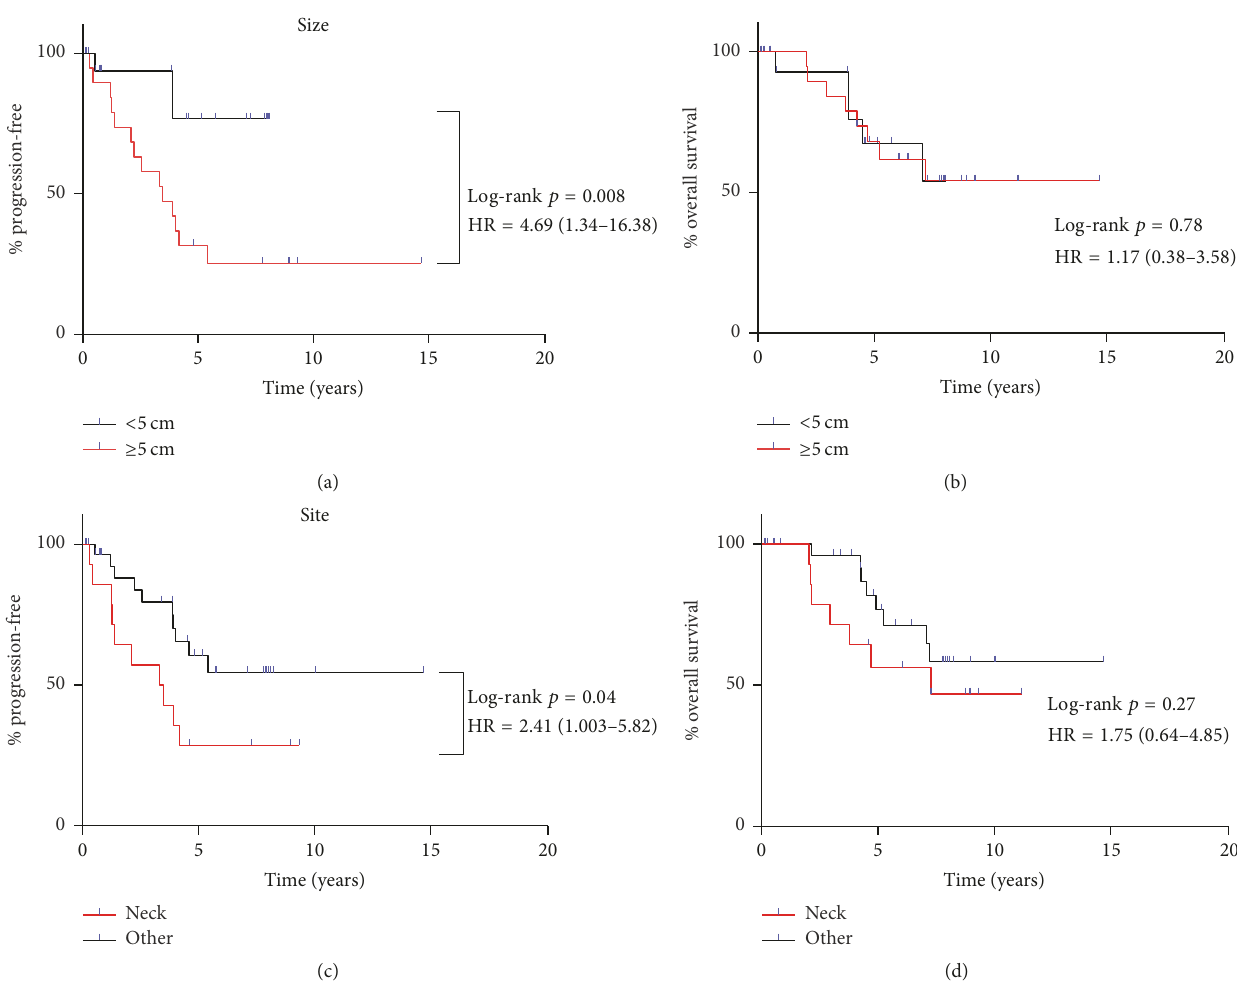
Figure 2: Kaplan-Meier curves revealed a significant difference in PFS between patients grouped according to the size of the primary tumor (a) and site of the primary tumor (c). There was no significant difference in OS between patients grouped according to the size of the primary tumor (b) and site of the primary tumor